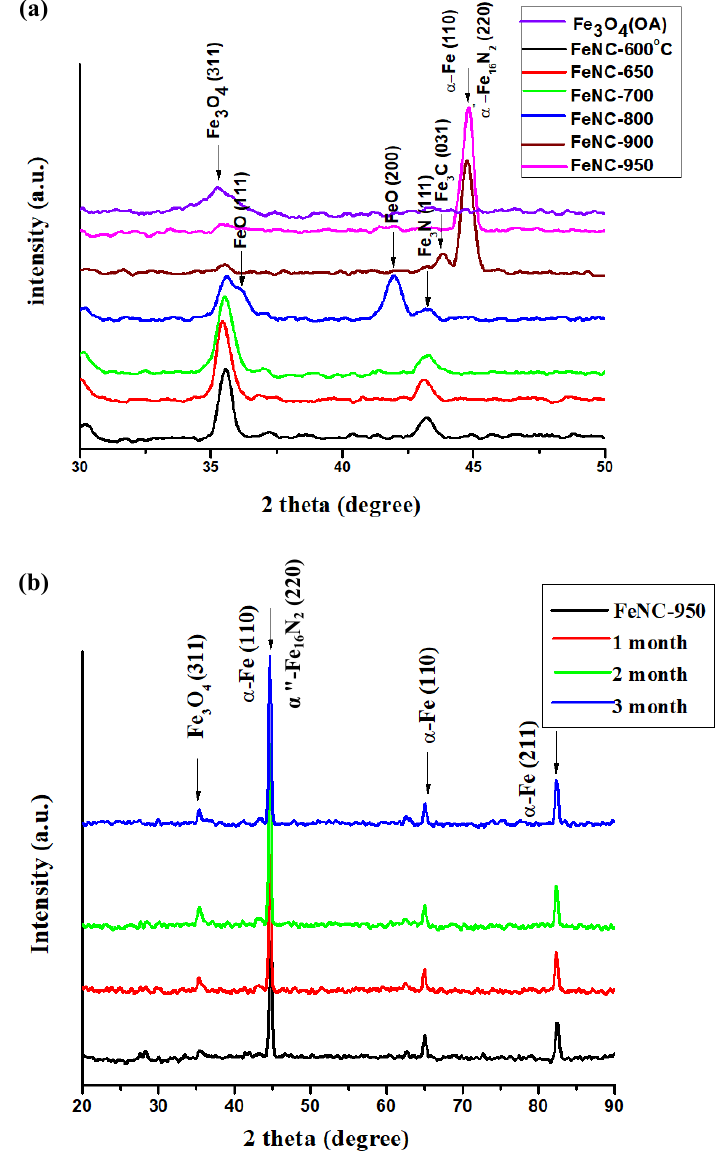
Figure 8. X-ray diffraction patterns of ( a ) FeNCs and ( b ) FeNC-950 staying in the open air for months. According to FWHM, the crystallite sizes for FeNC-900 and -950 are 1.15 and 3.75 nm, respectively (calculated from the X-ray diffraction patterns of Figure 8b α -Fe(110) peak), which are much smaller than TEM (Figure 6c) The size of α -Fe (or α (cid:48)(cid:48) -Fe 16 N 2 ) crystallites also increased with temperature from 900 to 950 ◦ C. The size of Fe 3 C based on Fe 3 C (031) plane in Figure 6c is 3.65 nm, which is also much smaller than the particles illustrated in TEM (Figure